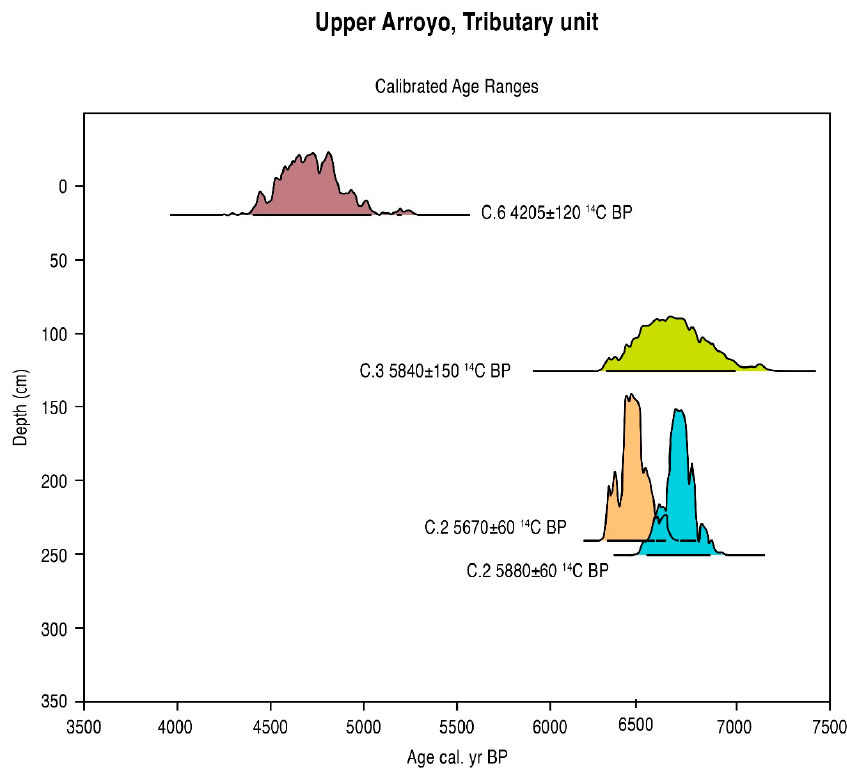
Quaternary 2023 , 6 , x FOR PEER REVIEW Figure 7. Age-depth graph with the 2-Sigma plot for the Upper Arroyo tributary sequence.